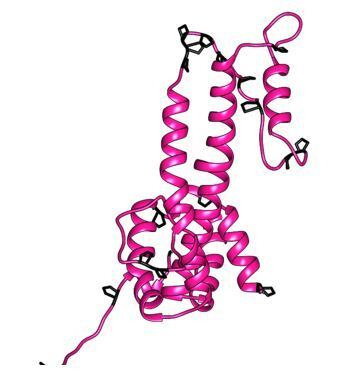
Model of the large-type CP of Tibetan frog.The model was generated with Modeller (Webb and Sali Current Protocols in Bioinformatics 54, John Wiley and Sons, Inc, 5.6.1-5.6.37, 2016.), using our DHBc structure as template. Prolines are highlighted in black.